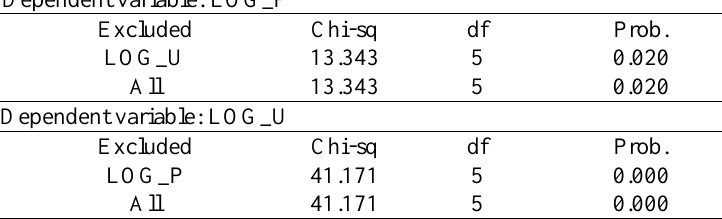
Table 7 : VAR Granger causality/block exogeneity Wald tests